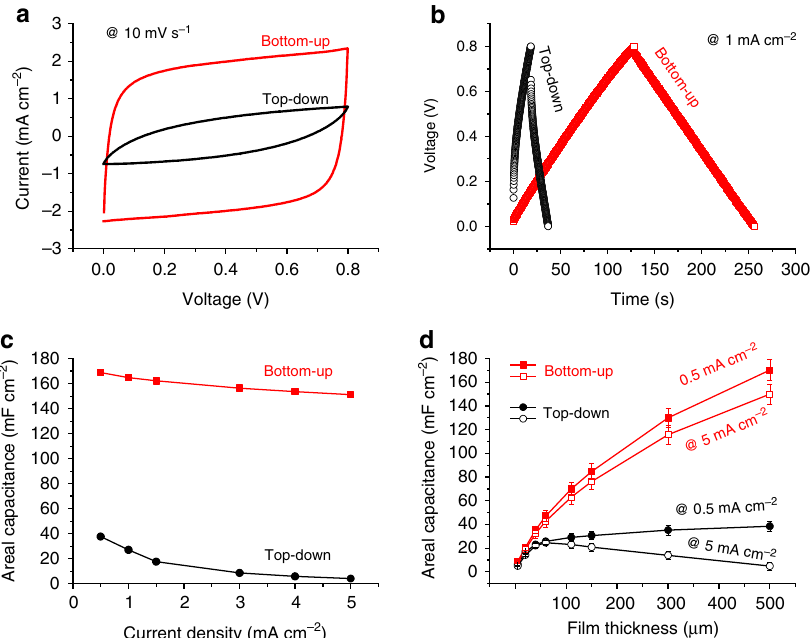
Fig. 2 Electrochemical properties of the top-down and bottom-up in fi lled FSSCs. a CV and b GCD curves of the different FSSCs. c Areal capacitances of the top-down and bottom-up in fi lled FSSCs at different current densities. d Thickness dependence of the areal capacitance for top-down and bottom-up in fi lled FSSC devices at 0.5 and 5 mA cm –